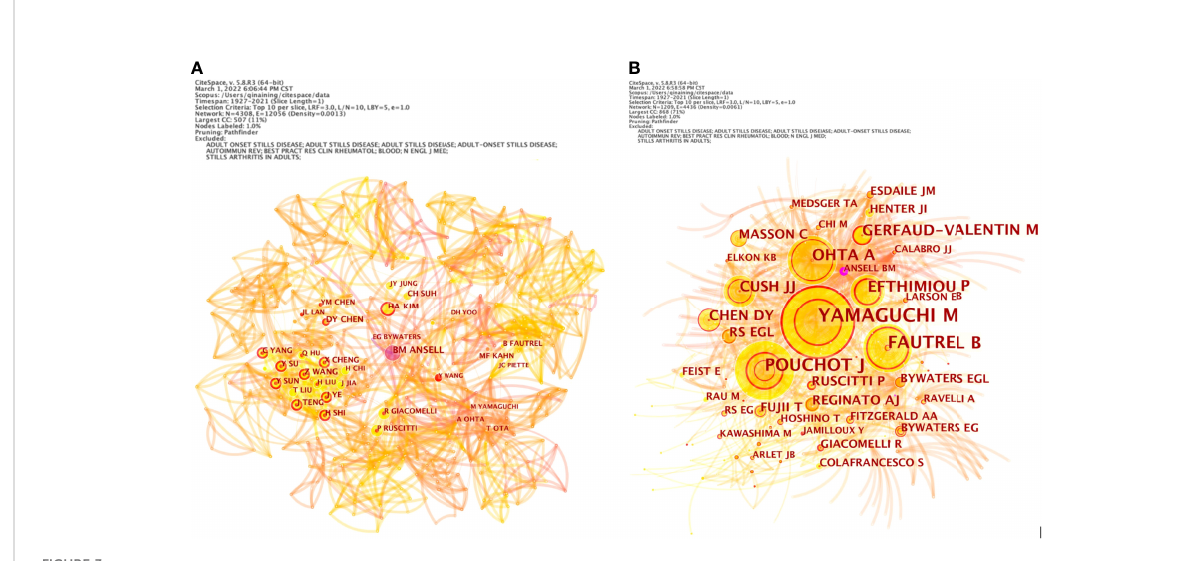
FIGURE 3 The network map of cooperation between authors (A) and co-authorship (B) of adult-onset Still ’ s disease articles from 1921 to 2021.